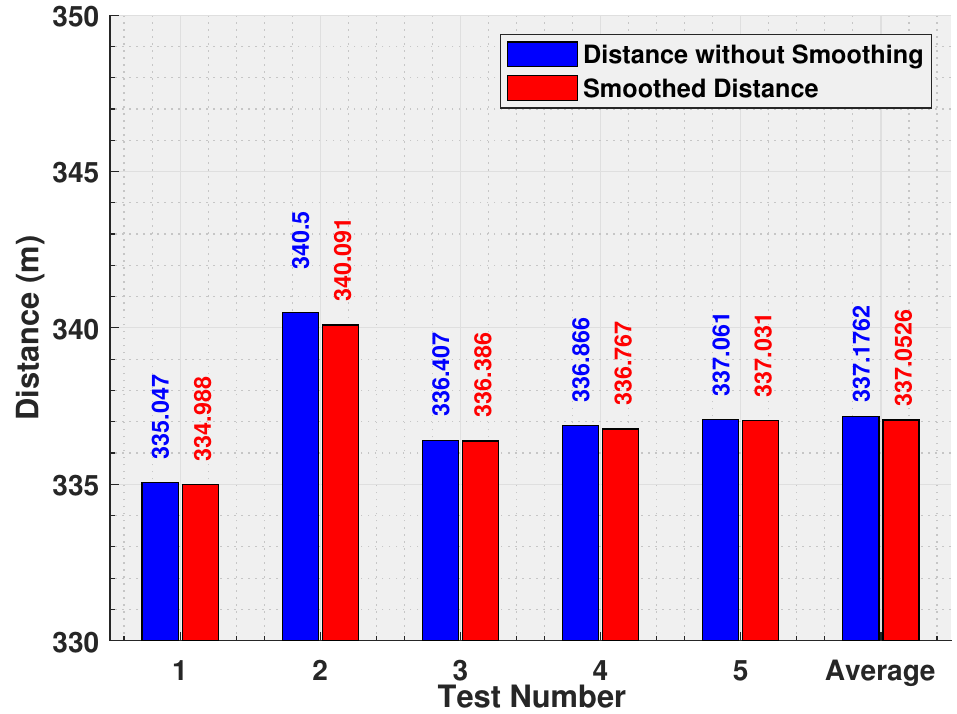
Figure 7. Comparison of the total travelled distance by a swarm of 5 UAVs for original trajectories and smoothed trajectories in